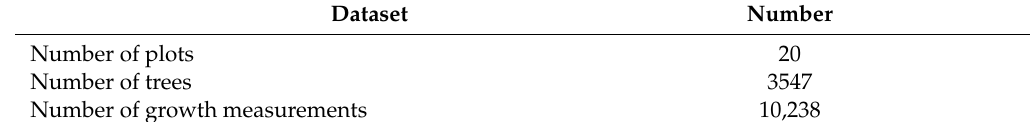
Table 1. Summary of study sites and tree-level measurements. The methods for calculating some of the variables are described later in the data processing section. Local neighborhoods are circular plots located around each subject